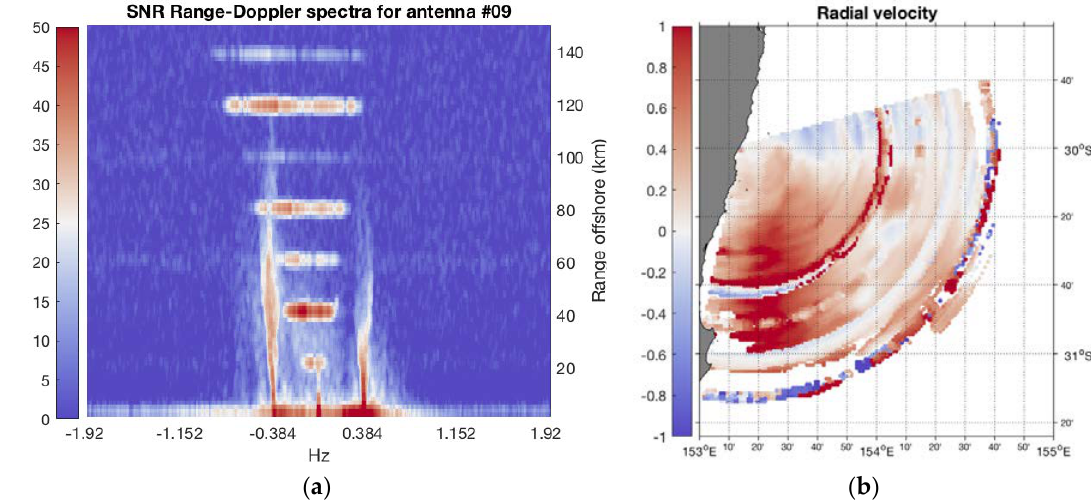
Figure 4. Range-Doppler spectra for Receive Antenna #09 at the Red Rock (RRK) HFR station ( a ) showing both the contamination from the 50 Hz across range (distance) from the receive array in the first order Bragg peaks and the spectral spreading over Doppler; ( b ) the radial velocity map extracted from this data set, documenting the spatial inconsistencies in radial velocity maps at fixed annular ranges from the antennas. Peak SNR values in these annular regions typically exceed 40 dB.